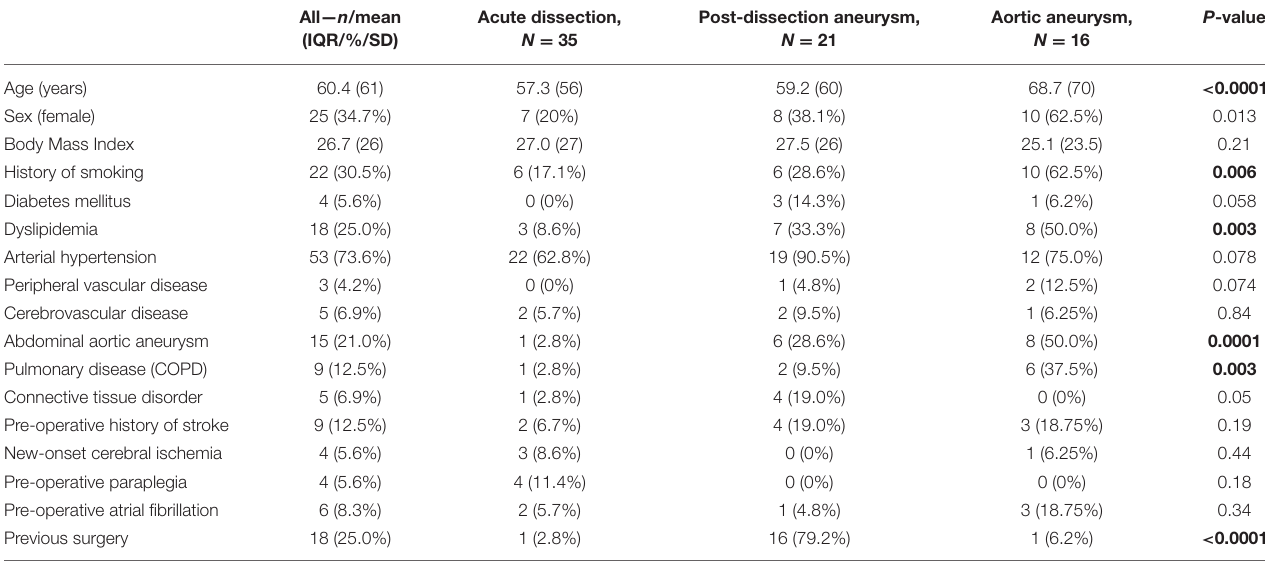
TABLE 1 | Demographic and pre-operative clinical